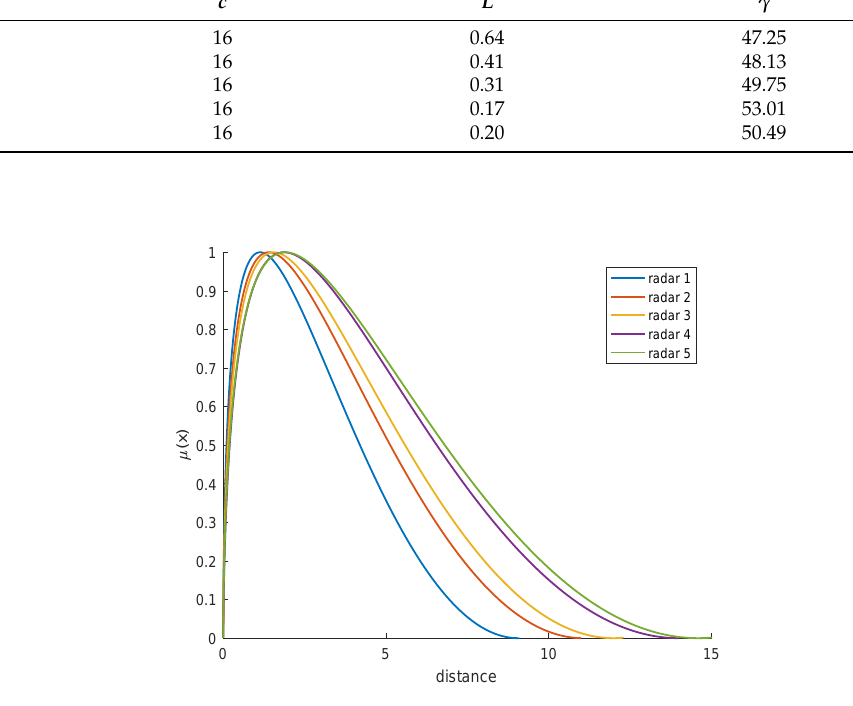
Figure 8. The relationship between distance and membership